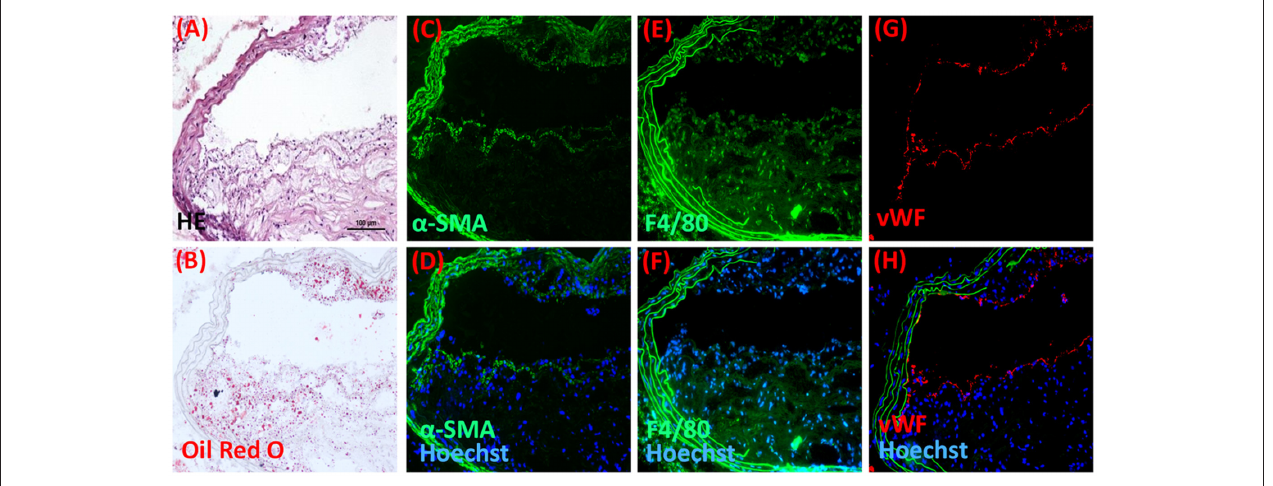
FIGURE 2 | Plaque composition in ApoE − / − after 16-20 weeks of lipid-rich diet feeding. Representative microscopic images stained with (A) hematoxylin-eosin and (B) Oil red O demonstarting general architecture and lipid content of the plaque respectively. Plaques were analyzed by immunohistochemistry for the presence of (C,D) α -SM-actin, (E,F) Macrophage (F4/80), and (G,H) endotheium (vWF), where (D,F,H) are respective images merged with green elastin auto fluorescence and blue fluorescence of Hoechst stained nuclei. Scale bar in A = 100 µ m and applies to (A–H) ( n = 7).